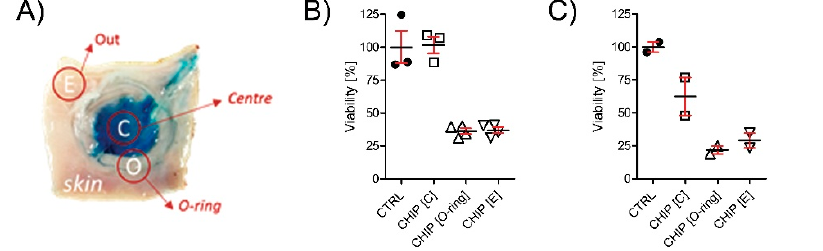
Figure 2. ( A ) Schematic representation of the 3 different skin regions taken into account for the viability evaluation by MTT assay. C, O and E denote the central part of the skin between the chambers, the part of the skin in contact with the O-ring and the outside region delimited by the O-ring, respectively. ( B,C ) Skin viability results after 12 and 24 h incubation in the 3D-PDC, with respect to the control